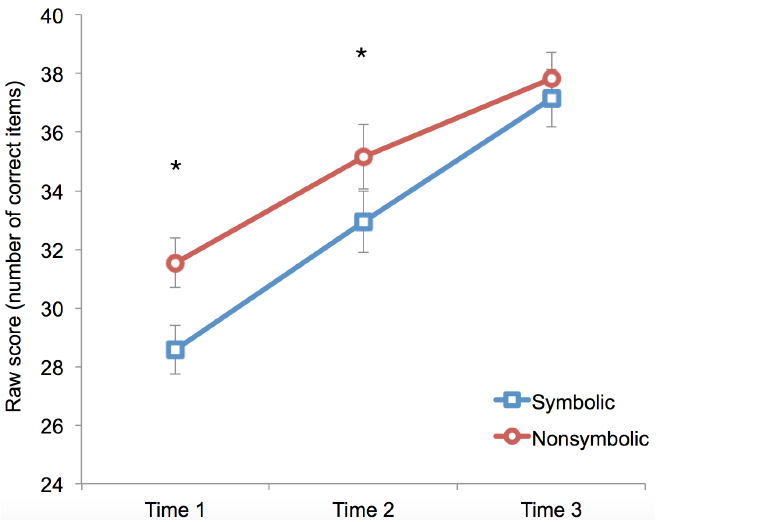
Fig 1. The development of symbolic and nonsymbolic skills in Grade